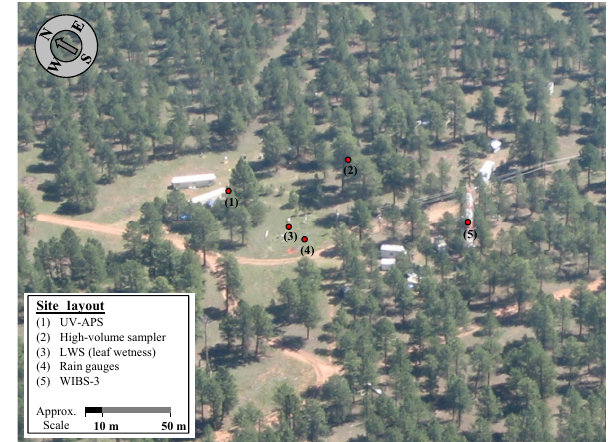
Figure 1. Aerial overview of BEACHON-RoMBAS field site at the Manitou Experimental Forest Observatory located northwest of Colorado Springs, CO. Locations of all instruments and sensors dis- cussed here are marked and were located within a 50m radius. Fig- ure adapted from Fig. 1a of Huffman et al.